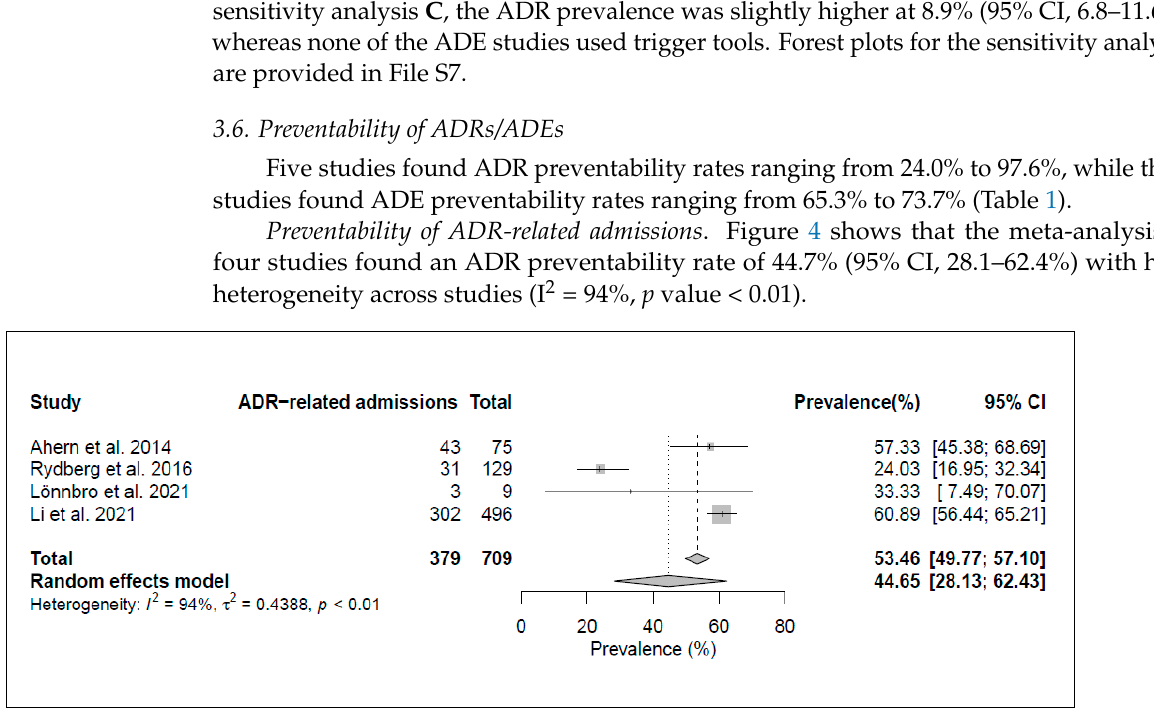
Figure 4. Forest plot of the pooled preventability rates of ADR-related hospital admissions [27,28,31,41] .